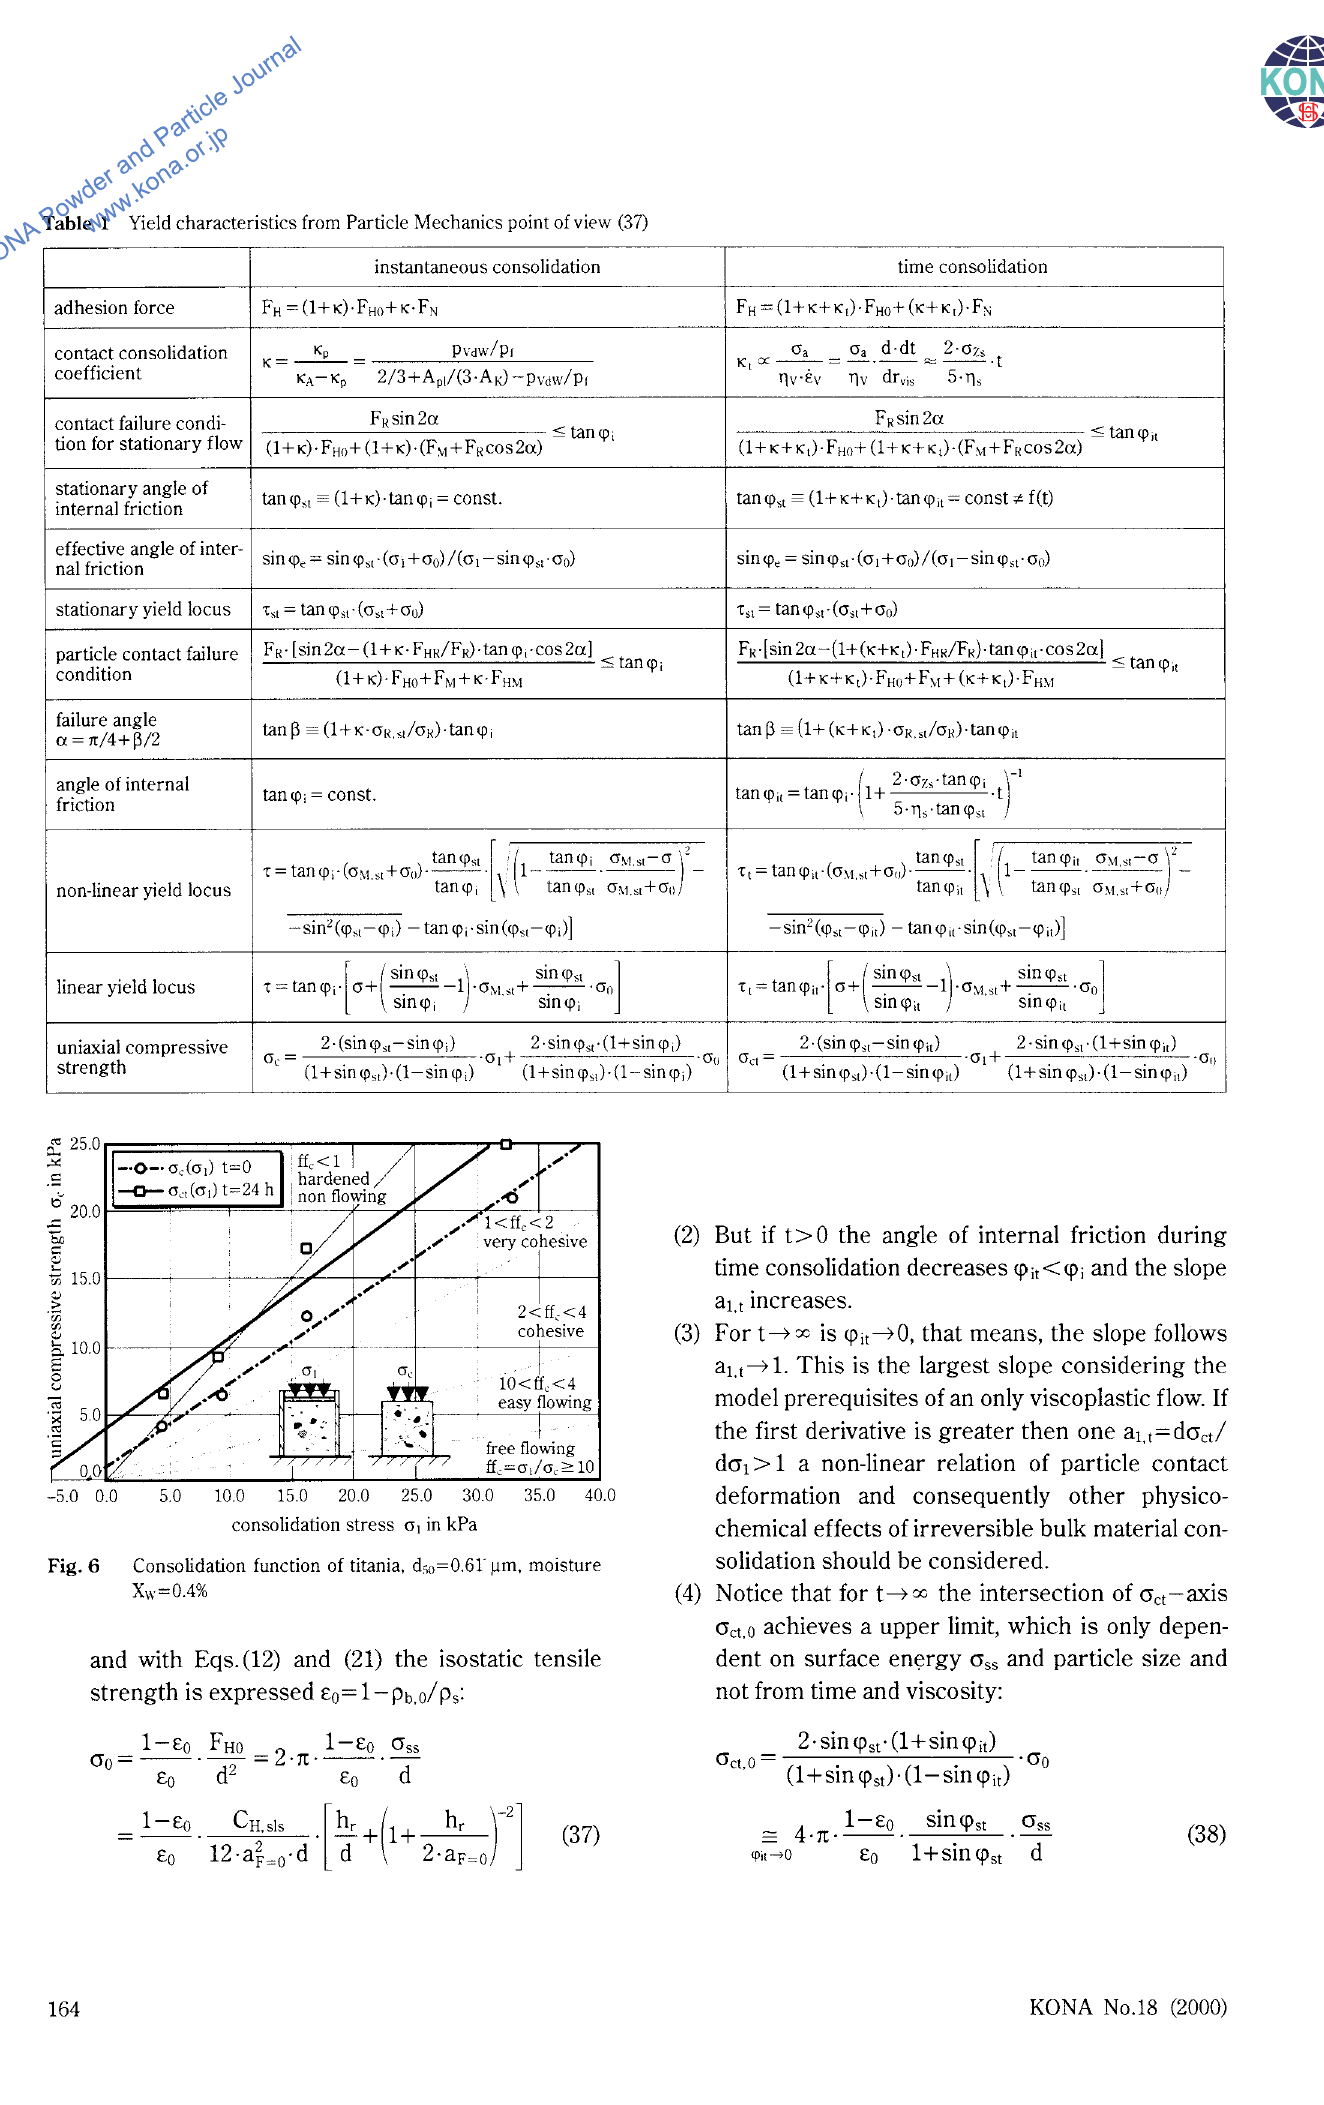
Table 1 Yield characteristics from Particle Mechanics point of view (37)